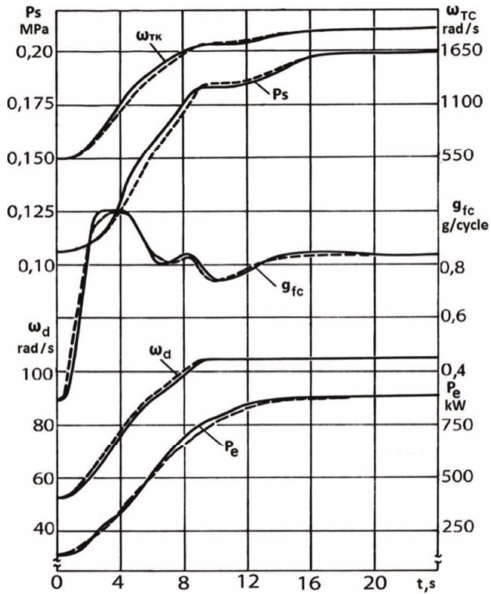
Fig. 4. Time characteristics of transient process in a8 С 22W diesel- generator unit: ω d , ω TC – angular velocity of crankshaft and turbine rotor; Р s – pressure of charge air; g fc – fuel charge per cycle; Р e – effective power of diesel; continuous line – experimental data; dashed line – calculated